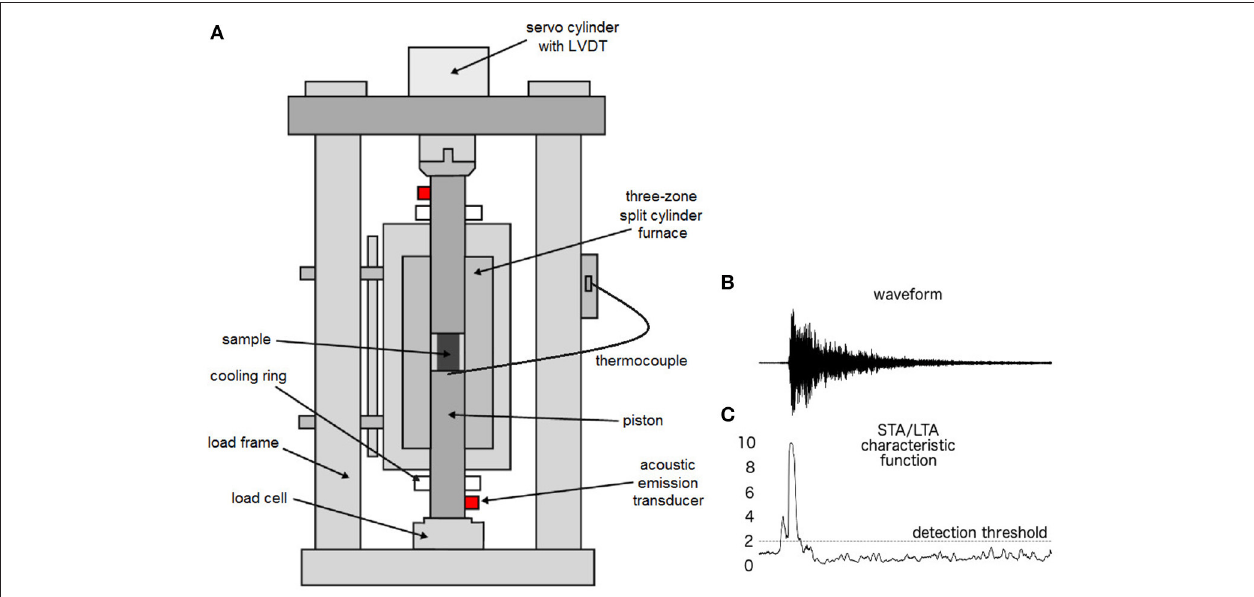
FIGURE 1 | Experimental technique employed here. (A) The experimental set up at the Ludwig-Maximilians-Universität, Munich, showing a uniaxial press with high temperature furnace in the sample zone, capable of applying up to 300 kN. AE sensors are fitted at the top and bottom of the rig in direct contact with the single-piece pistons which in turn are in direct contact with the sample during operation. (B) An example waveform from a single experiment (see Figure 6 ). (C) The STA/LTA characteristic function showing that the detection threshold is exceeded at the onset of the AE event displayed in (B) .